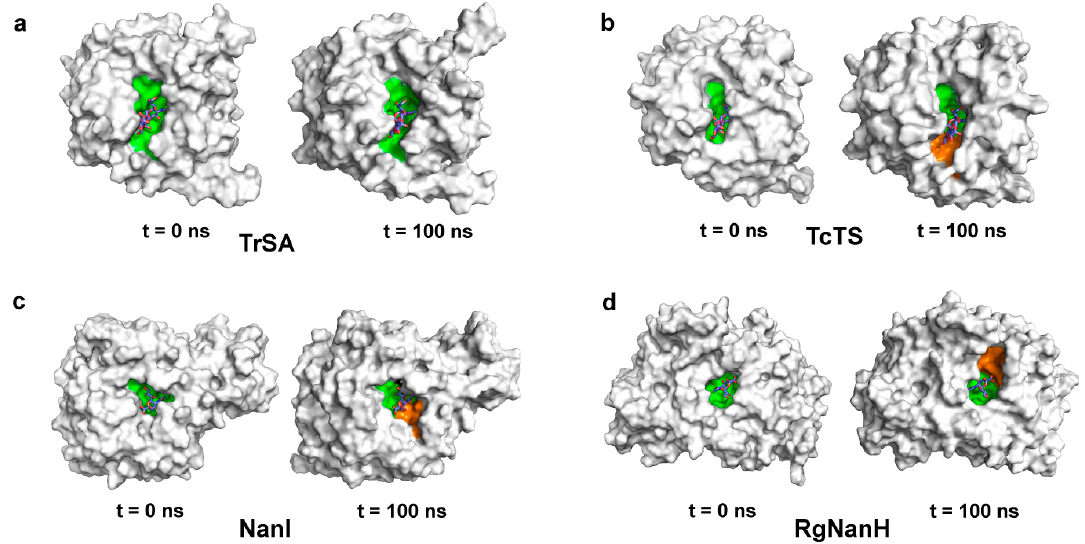
Figure 3. The conformational transition of GH33 sialidases in MD simulations. The proteins are shown in surface models, the innate active site and the new cleft of the enzyme are highlighted in green and orange, respectively. The conformational transition of TrSA, TcTS, NanI and RgNanH are shown in ( a – d ), respectively.